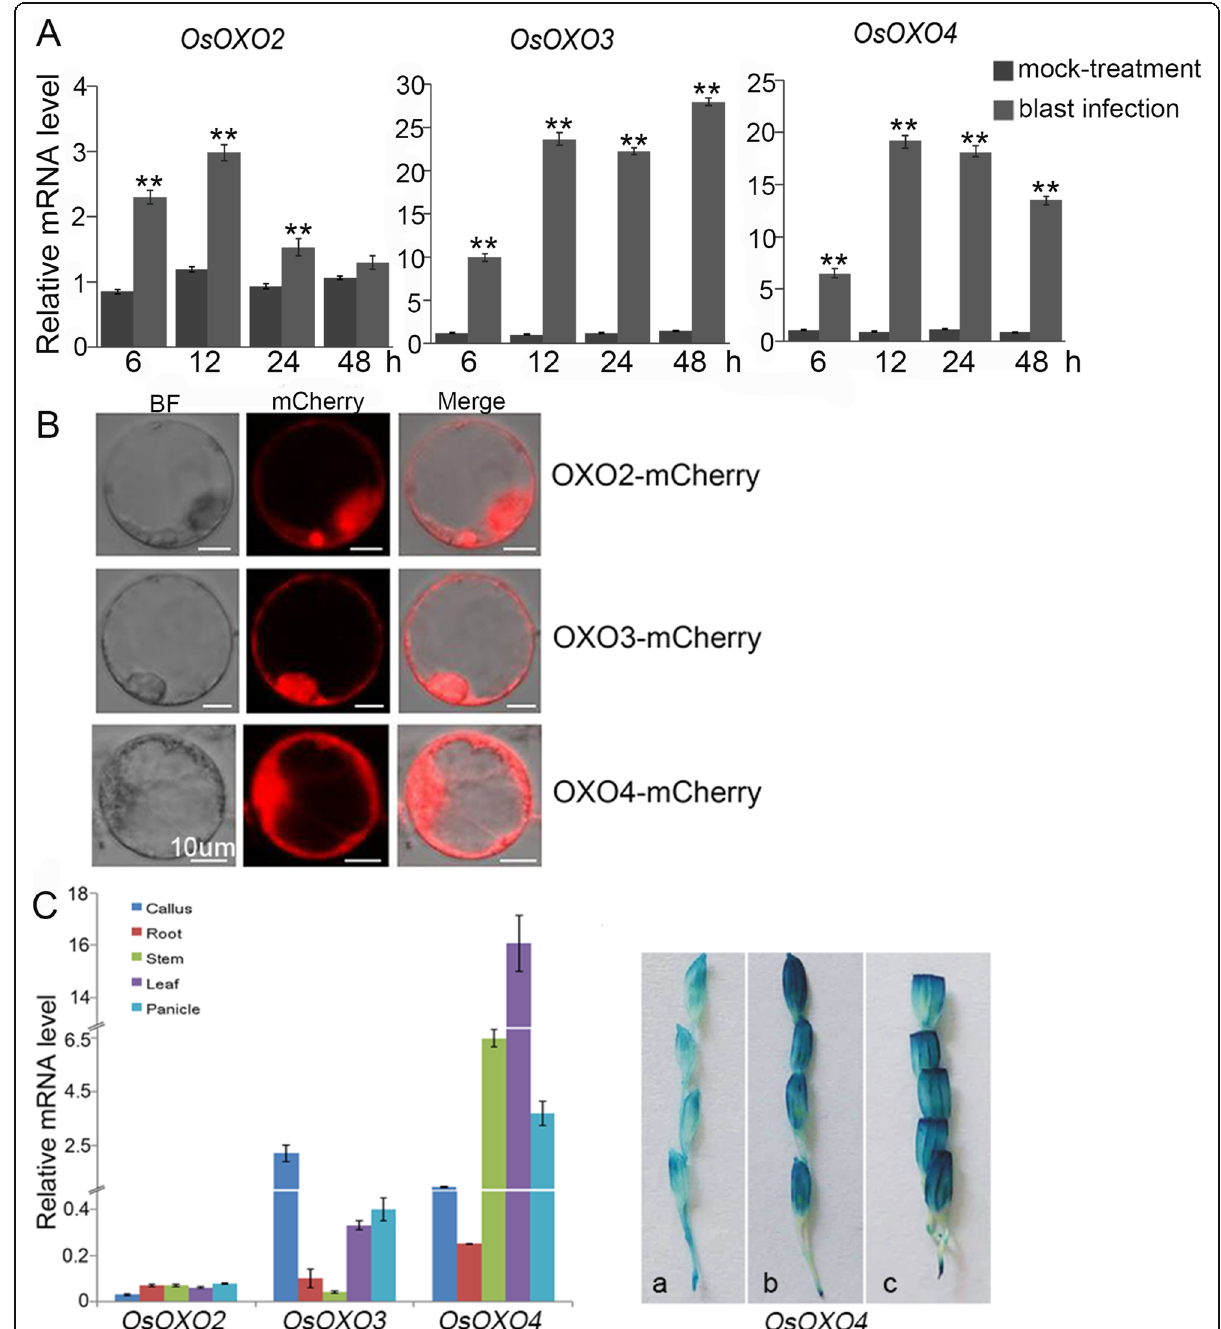
Fig. 1 The temporal and spatial expression patterns of OsOXO2 , OsOXO3 and OsOXO4 and their subcellular localizations. A. The expression of OsOXO2 , OsOXO3 and OsOXO4 were assessed by quantitative RT-PCR at 6 h, 12 h, 24 h, 48 h after panicle blast inoculation. Error bars indicate the standard deviation (SD) from three biological replicates and ** indicates a statistically significant difference compared with mock (t test, P < 0.01). B. Sub-cellular localization of OsOXO2, OsOXO3 and OsOXO4 in rice protoplasts. Bar = 10 μ m. C. Expression analysis of OsOXO2 , OsOXO3 and OsOXO4 in different rice tissues by quantitative RT-PCR and GUS activity of OsOXO4 in the panicles of Nipponbare . Error bars indicate the standard deviation (SD) from three biological replicates. a, panicle at the early booting stage; b, panicle at the booting stage; c, panicle at the